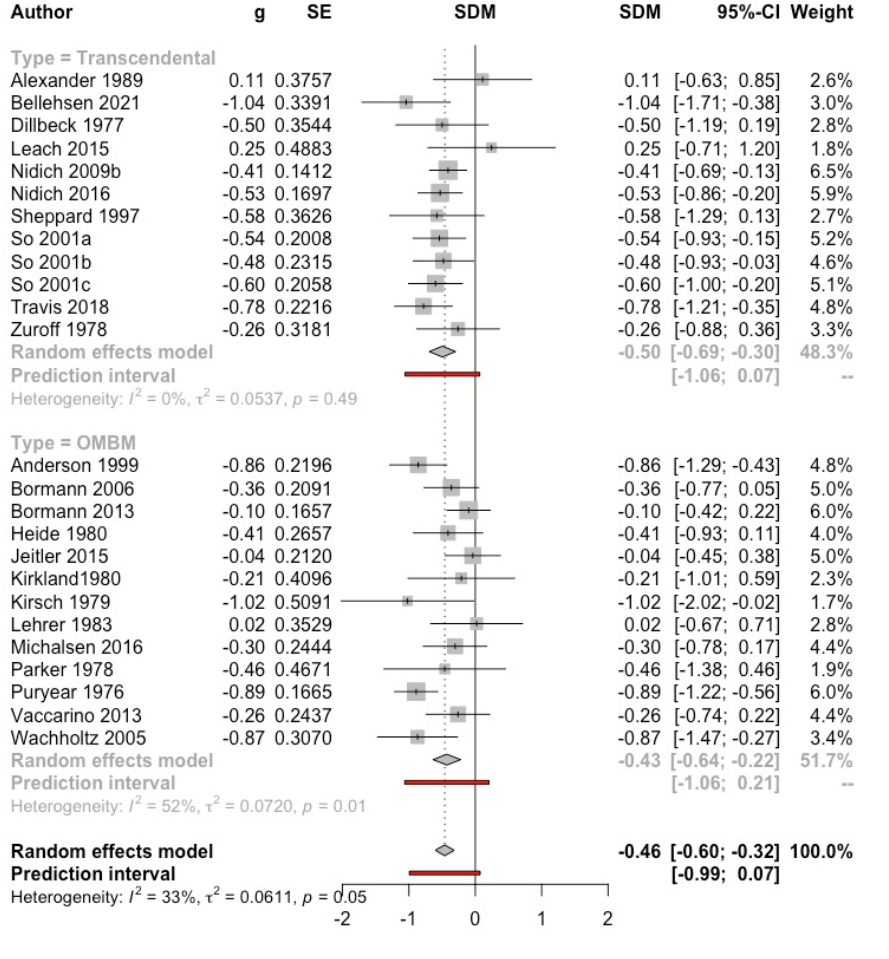
Figure 2. Effect on anxiety (meditation vs. control). Predictive intervals are represented in red.